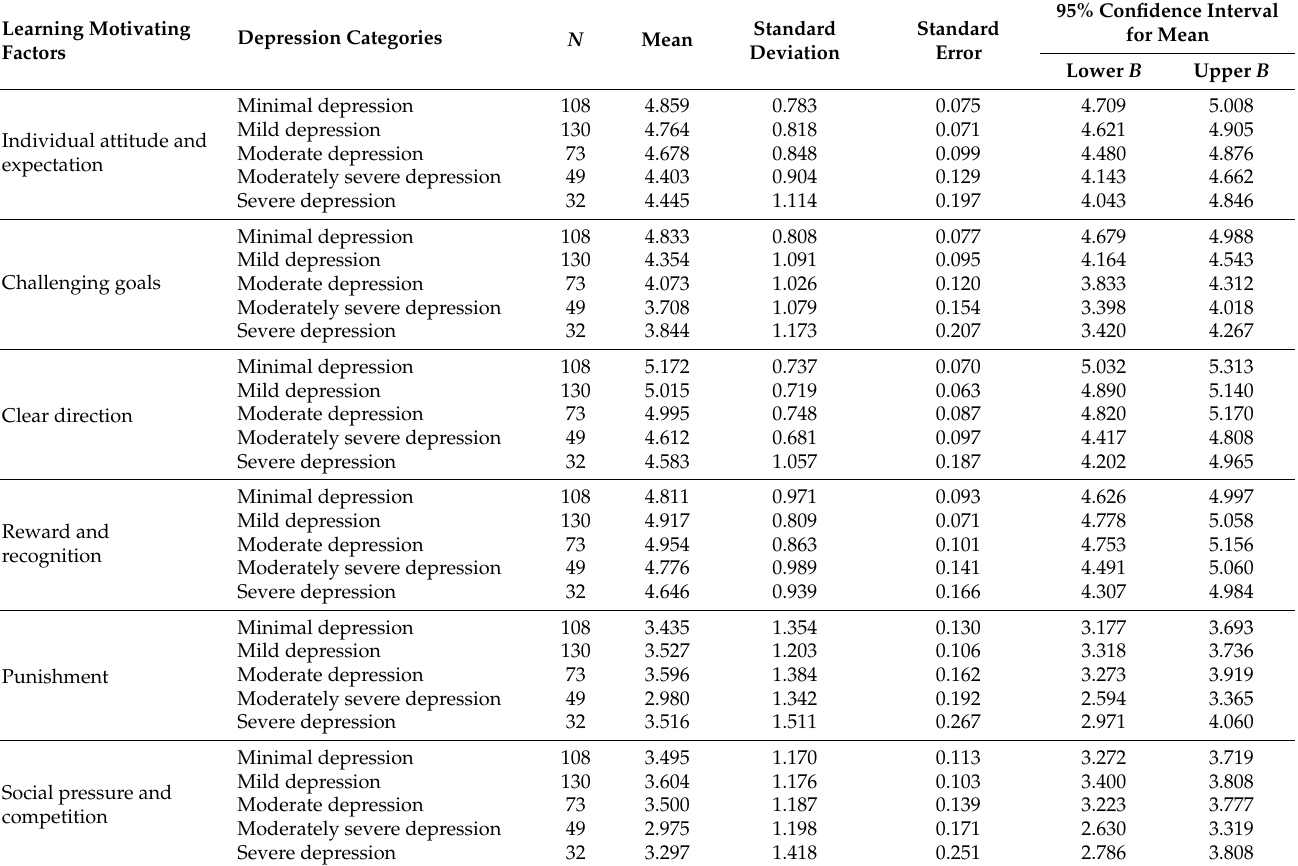
Table 8. Differences in learning motivating factors based on the PHQ-9